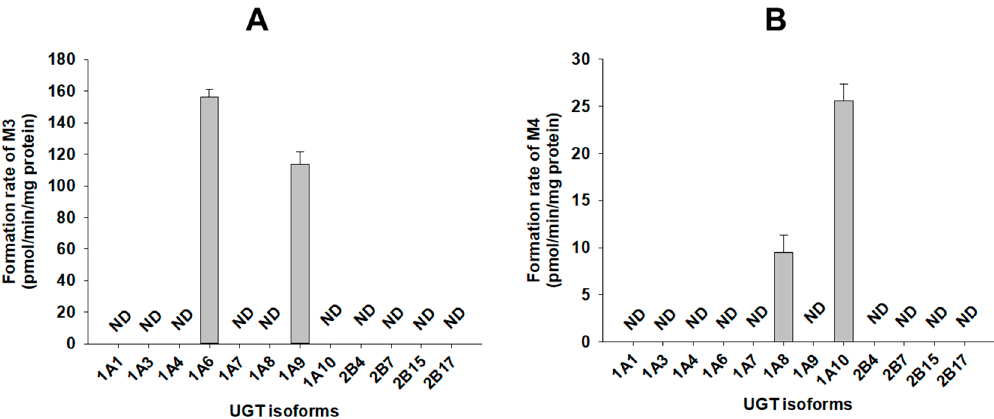
Figure 6. Rates of formation of ( A ) 4-hydroxybenzoic acid glucuronide (M3) from 500 µ M 4-hydroxybenzoic acid (M2) and ( B ) catalposide glucuronide (M4) from 400 µ M catalposide by human cDNA-expressed UGT enzymes. All data are means ± SD ( n = 3). ND: < 27 pmol / min / mg protein for M3, < 0.83 pmol / min / mg protein for M4.